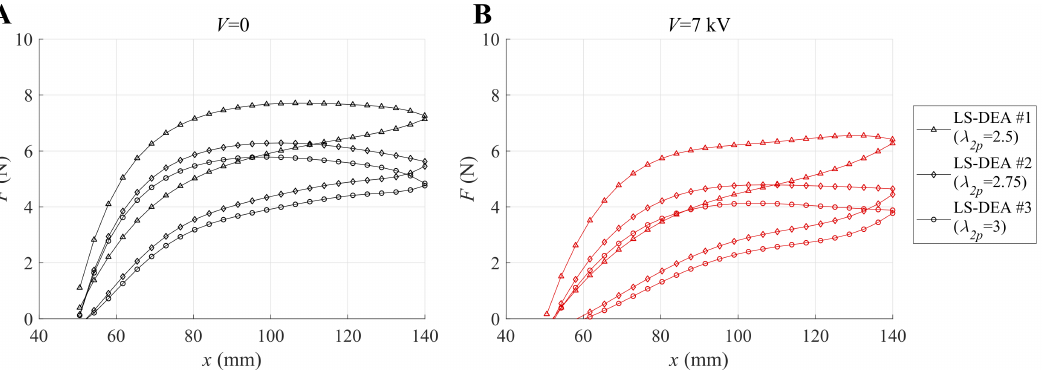
Figure 6. Stabilized force-displacement curves for three different LS-DEA prototypes (see Table 2) subject to cyclic displacements ( ∆ x = 90 mm) at ( A ) V = 0 kV and ( B ) V = 7